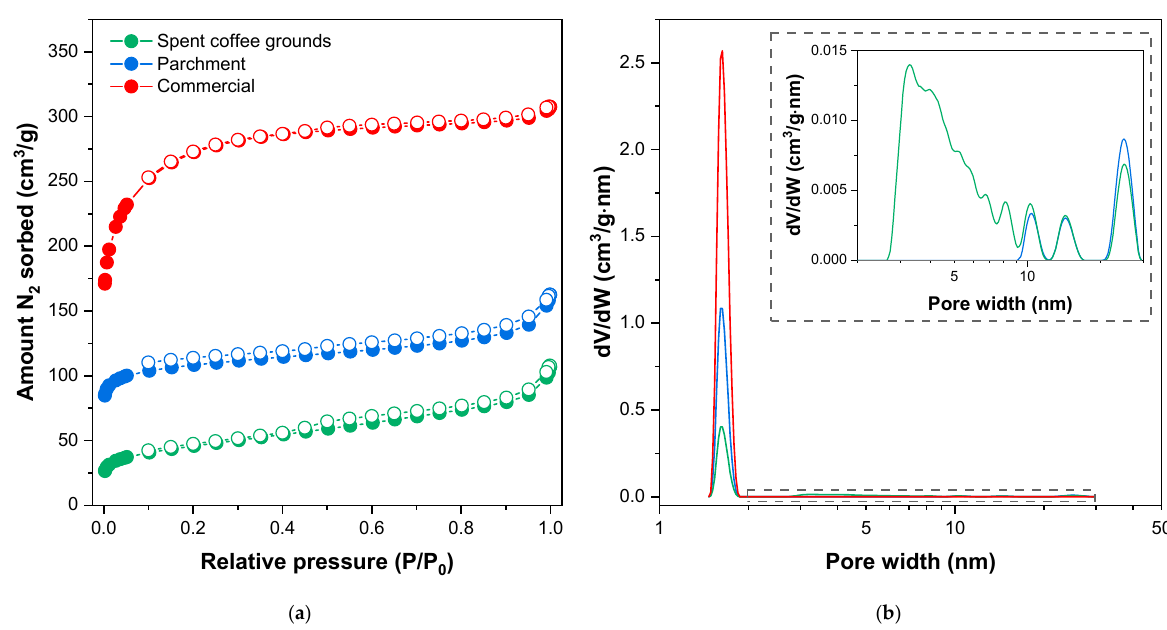
Figure 3. ( a ) N 2 sorption isotherms, and ( b ) differential pore size distribution of spent coffee grounds, parchment, and commercial activated carbons (inset comes from the dashed rectangle for pore widths between 2 and 30 nm). Table 1. Porosity data derived from N 2 sorption measurements at 77 K.